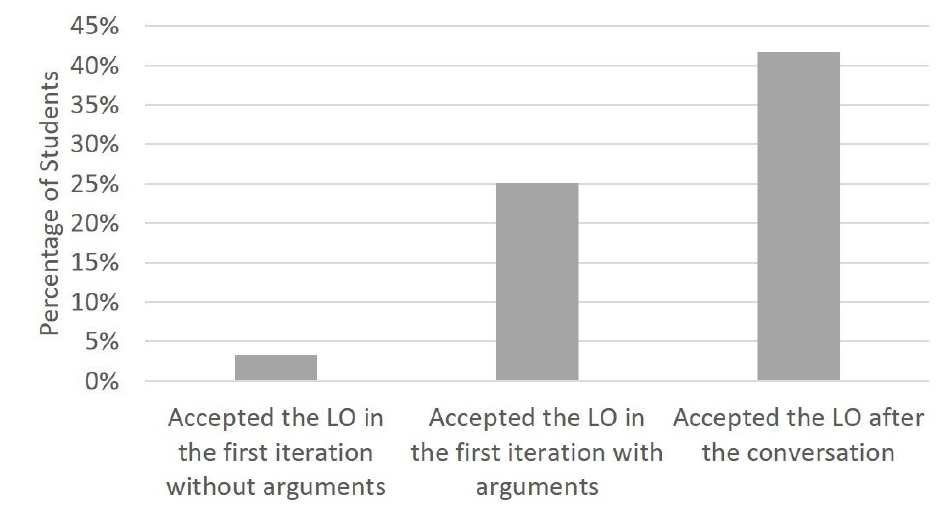
Figure 8. Average % of students that accepted the recommendation in the 1st iteration (without and with explanations), and at the end of the conversation.